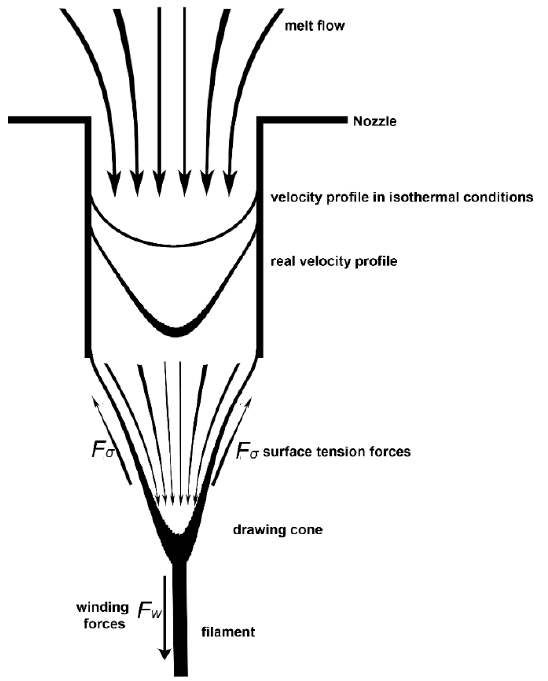
Figure 4. Scheme of the distribution of flow velocity in the basalt melt through the nozzle and in the drawing cone. ( Fw : winding forces, F σ : surface tension forces).